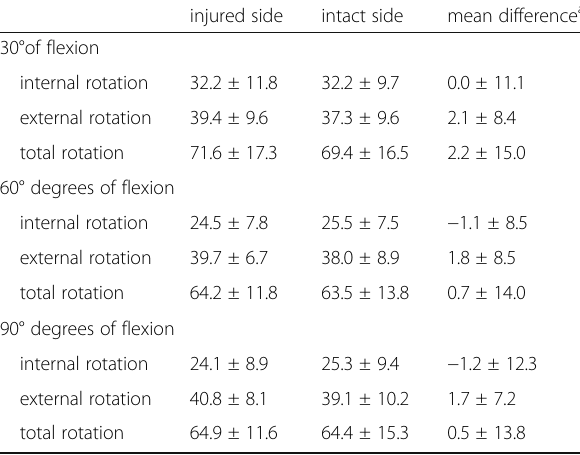
Table 2 The amount of tibial rotation in degrees in 26 pair of knees suspected for unilateral ACL injury with a 6 Nm